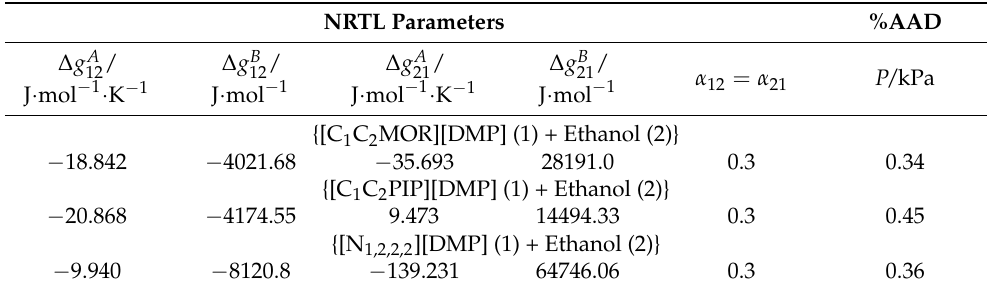
Table 5. NRTL parameters fitted to experimental VLE data of {IL (1) + Ethanol (2)} with the average absolute deviation (AAD) and for the systems